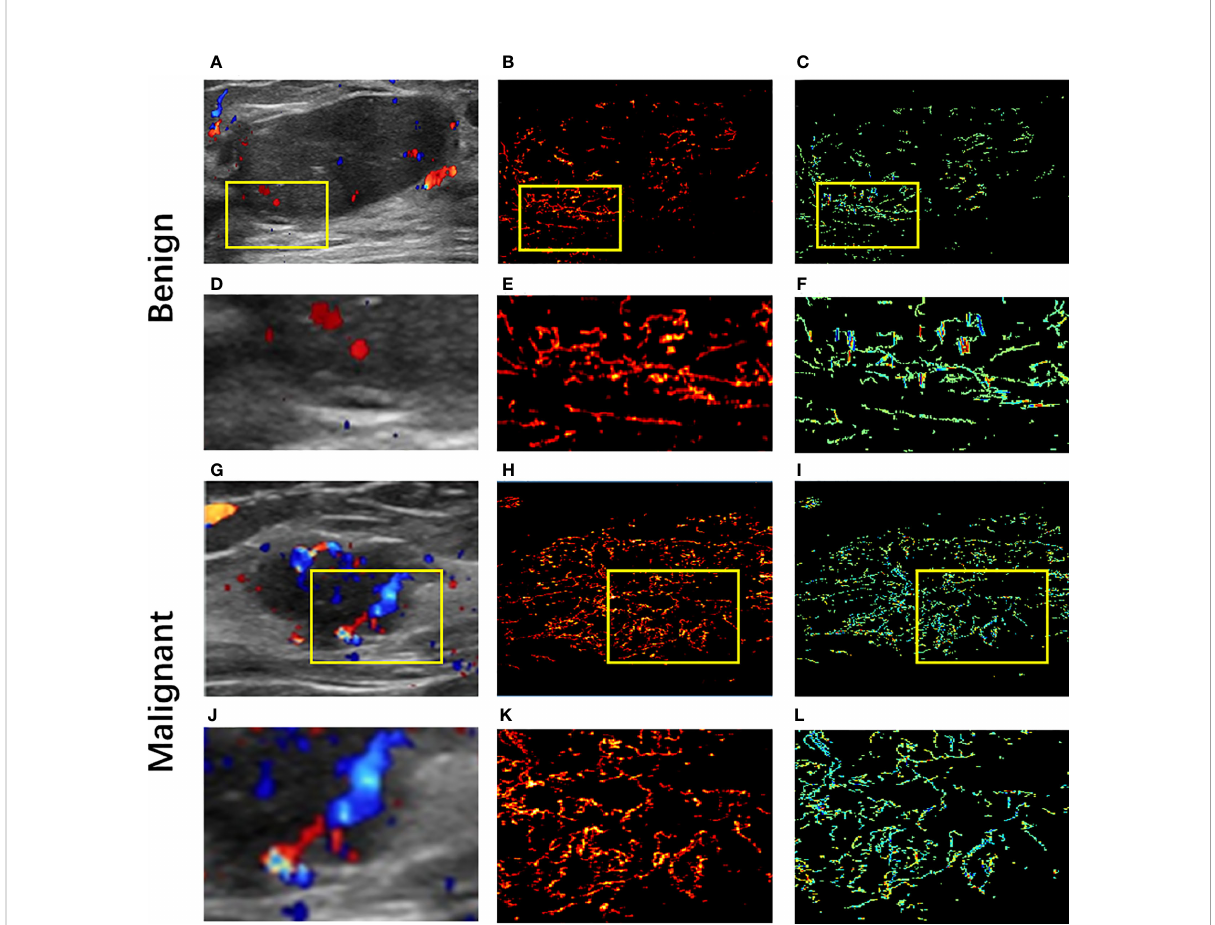
FIGURE 2 Ultrasound images of benign and malignant breast masses respectively. (A, G) Color-Doppler fl ow images of benign and malignant breast masses respectively; (B, K) super-resolution images of benign and malignant breast masses respectively; (C, I) super-resolved velocity images of benign and malignant breast masses respectively. (D – F) Zoomed-in sections as the yellow box indicated in (A – C) ; (J – L) Zoomed-in sections as the yellow box indicated in (G – I)